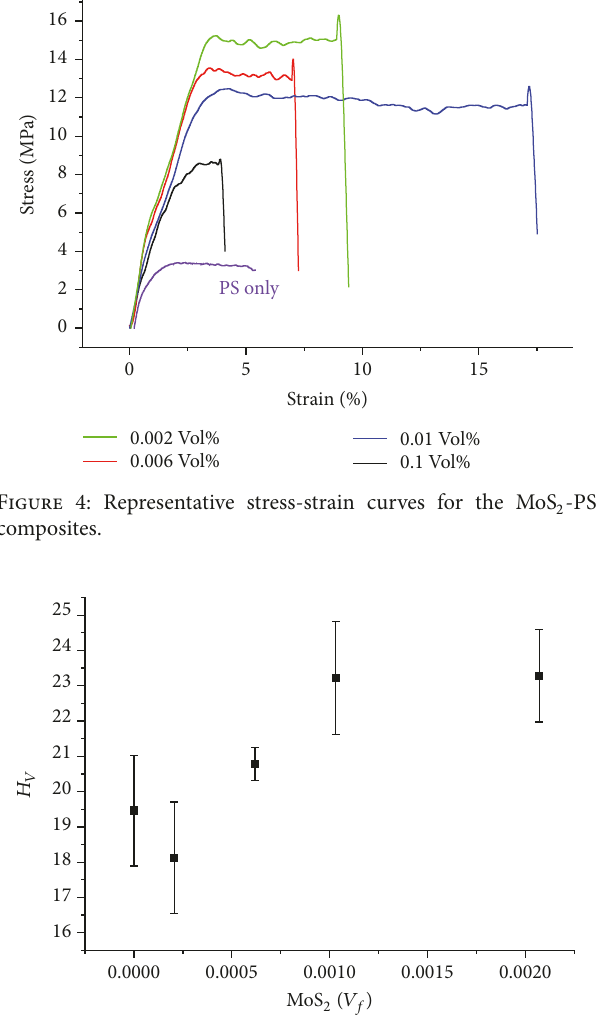
Figure 5: Hardness results for MoS 2 -PS composites as a function of MoS 2 volume